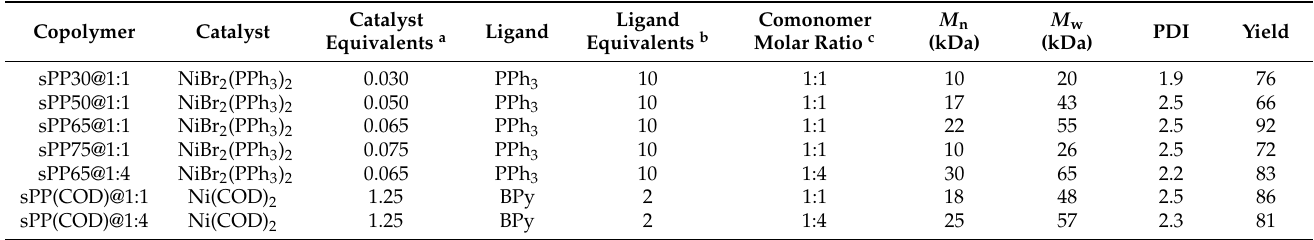
Table 1. Summary of feed ratios of monomers, catalysts, and ligands, GPC results, and yields of block copolymers.